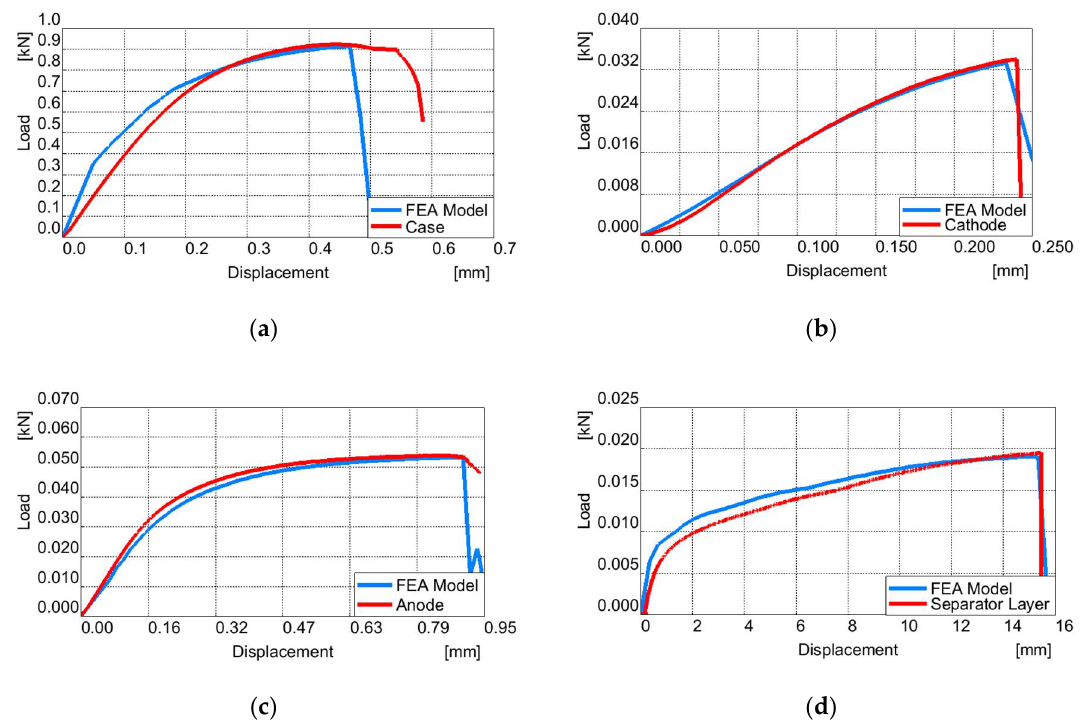
Figure 4. Comparison of experimental and numerical tensile load-displacement curve ( a ) case ma-